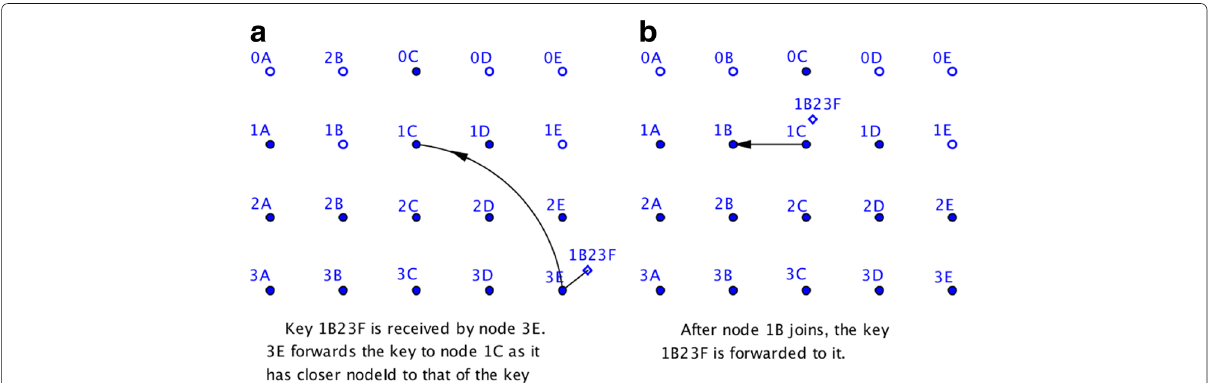
Fig. 6 Key mapping in a 2-d SHAM. a Key 1B23F is received by node 3E. 3E forwards the key to node 1C as it has closer nodeld to that of the key.